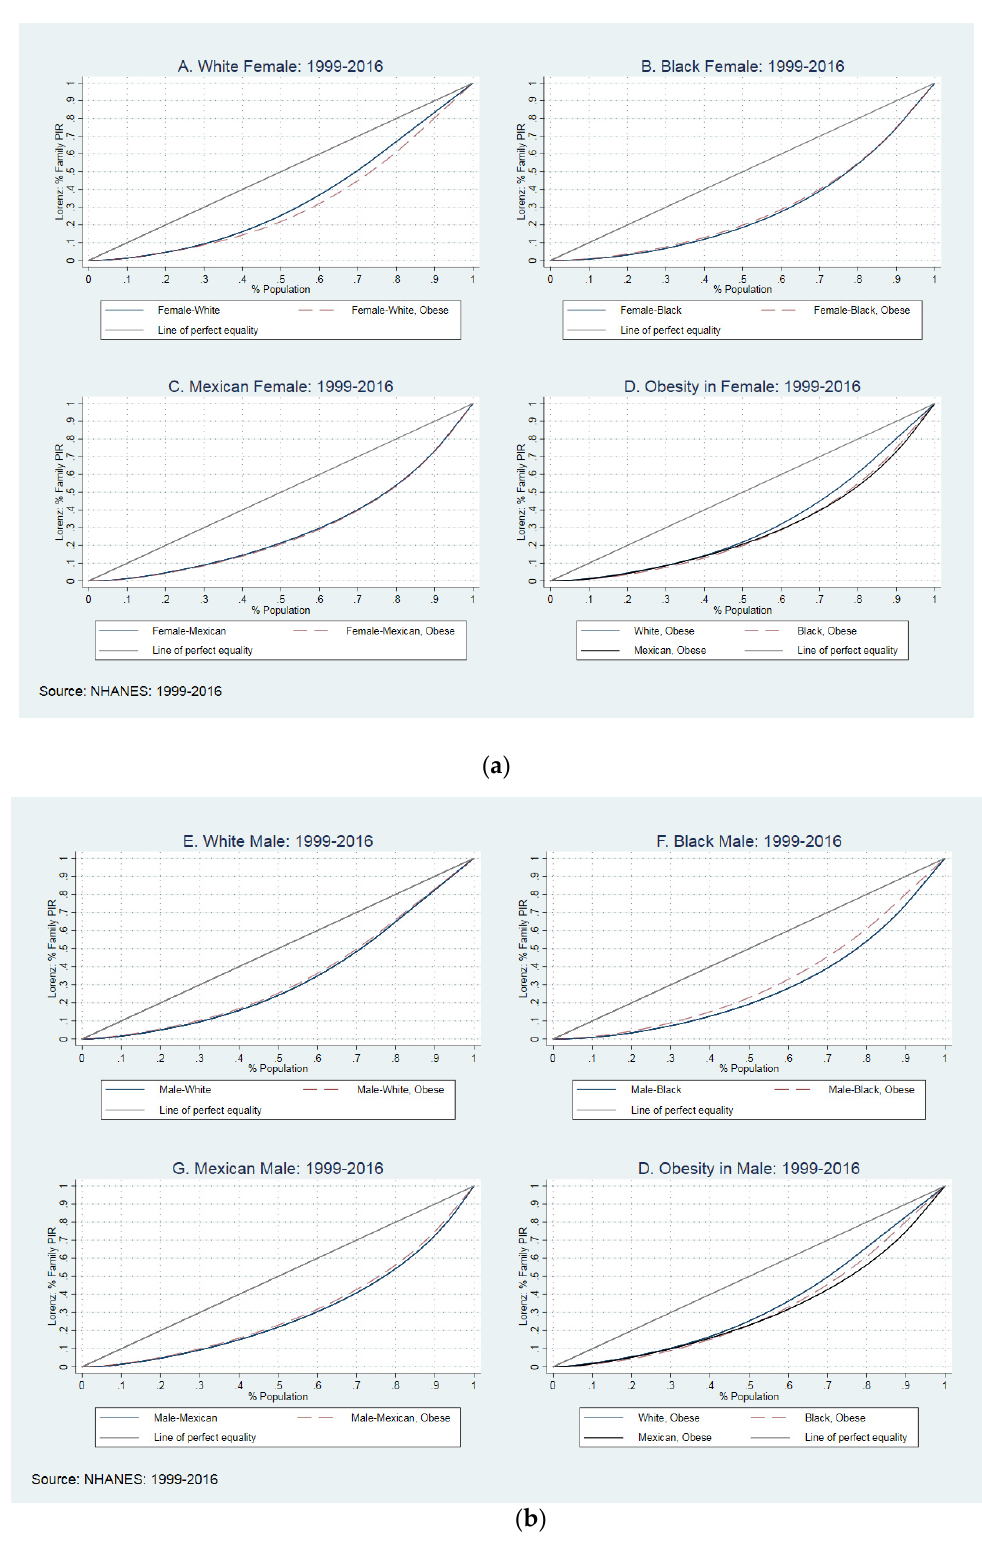
Figure 2. ( a ) The Lorenz curves and Gini coefficients in women, 1999–2016. ( b ) The Lorenz curves and Gini coefficients in men, 1999–2016.